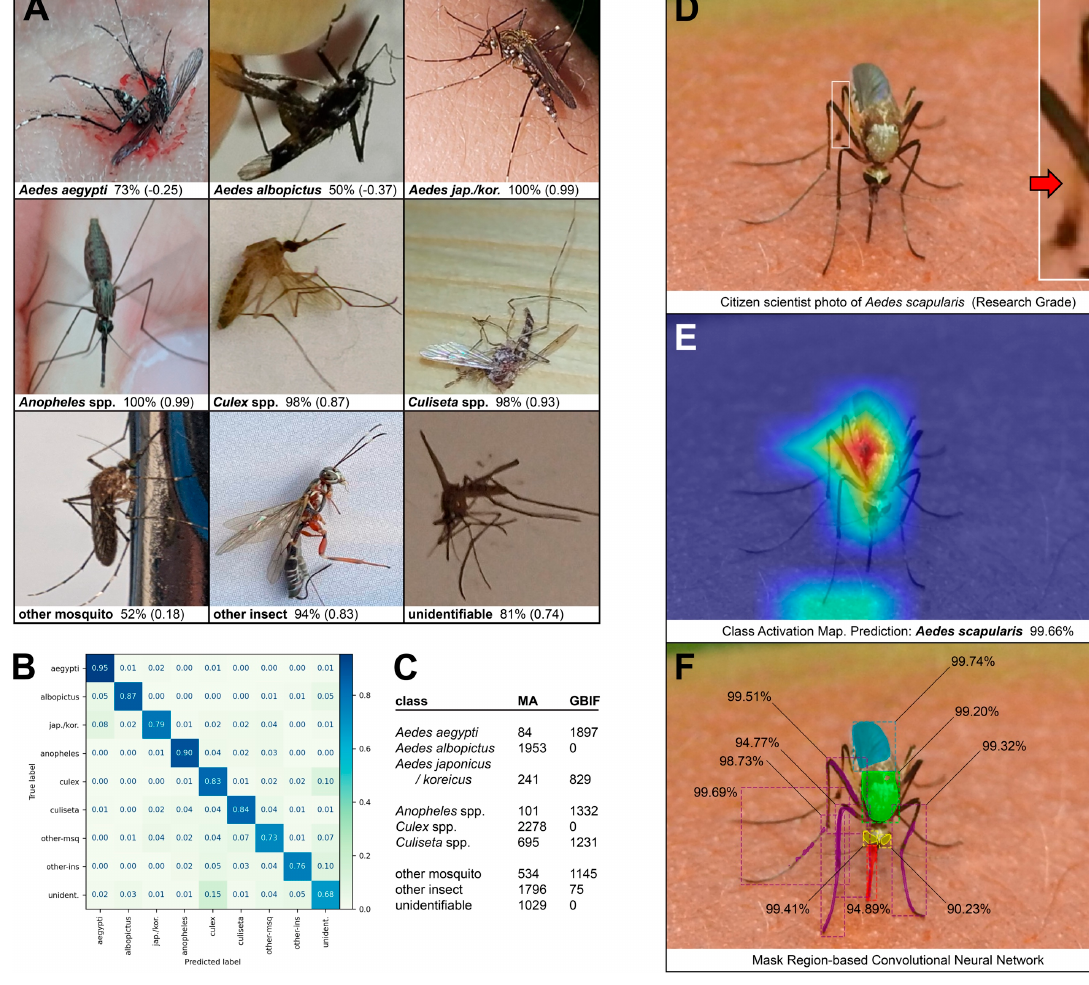
Figure 6. Artificial intelligence (AI) analyses of citizen science photos. ( A ) Mosquito Alert (MA) submissions correctly classified by AI, as verified by entomologists. The percentage is the model’s prediction confidence. The number in parentheses is the difference between the prediction confi- dence and the threshold of acceptance selected from the receiver operating characteristic curve (a value between − 1 and 1, where 0 means that the prediction con fi dence is on the threshold). ( B ) Confusion matrix of classification accuracies from the validation set. ( C ) Number of images from the MA and Global Biodiversity Information Facility (GBIF) databases that were included in the training set. ( D ) Photo of Aedes scapularis submitted to iNaturalist during our summer campaign, modified here with a white box and inset. In addition to the diagnostic gold patch on the anterior scutum, the diagnostic pale patch on the anterior hind tibia is also visible (inset). ( E ) Class activa- tion map, illustrating the relative weighting of pixels used in the species classification; warmer colors correspond to higher weights. Visualization represents the feature map from the last convo- lutional layer, overlayed at 50% opacity onto a grayscale version of the original photo. We applied a threshold of 110 to the feature map to show only those pixels that have contributed most to the final output. The percentage is the model’s prediction confidence. ( F ) Anatomical regions automat- ically identified using a mask region-based convolutional neural network approach [40]. Results yielded localization (dashed bounding box) and pixel-wise segmentation of each region: proboscis (red), head (yellow), thorax (green), wing (blue), and leg (purple). Prediction confidence (percent- age) for each region was manually overlaid onto the results image.